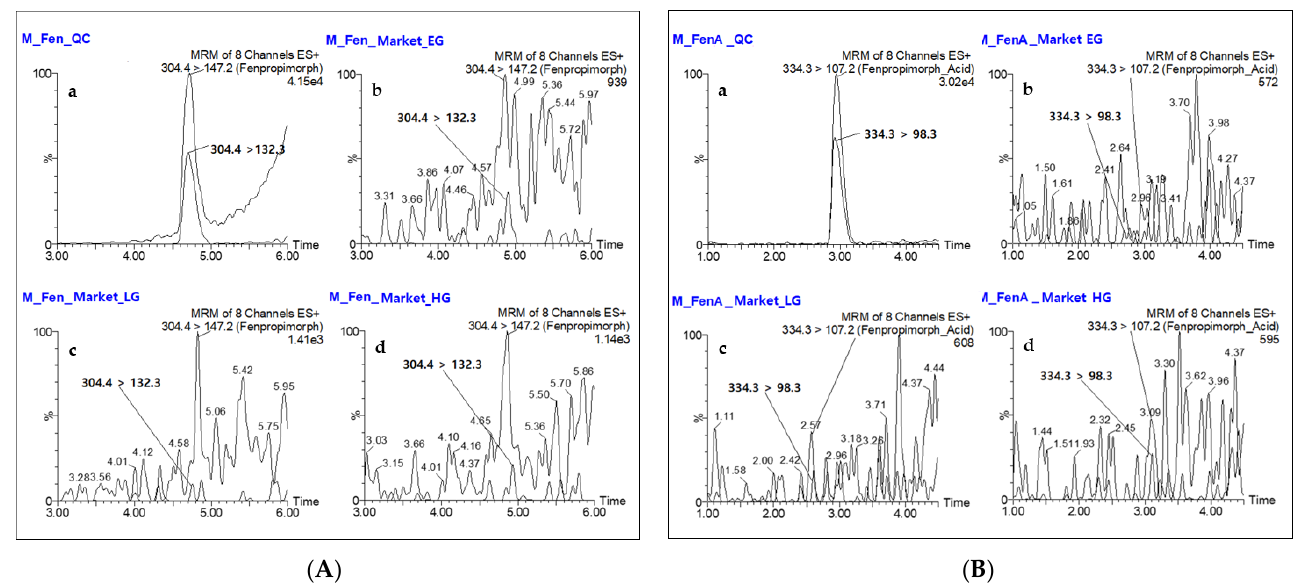
Figure 3. Typical LC-MS/MS chromatograms of two transitions of fenpropimorph ( A ) and fenpropimorph acid ( B ) in real milk samples: ( a ) samples spiked at 0.01 µ g/kg; ( b – d ) samples from domestic markets. The milk samples from three markets are presented as typical examples of real samples. Table 7. Relative differences in the ion ratios of fenpropimorph and fenpropimorph acid in the real samples 1